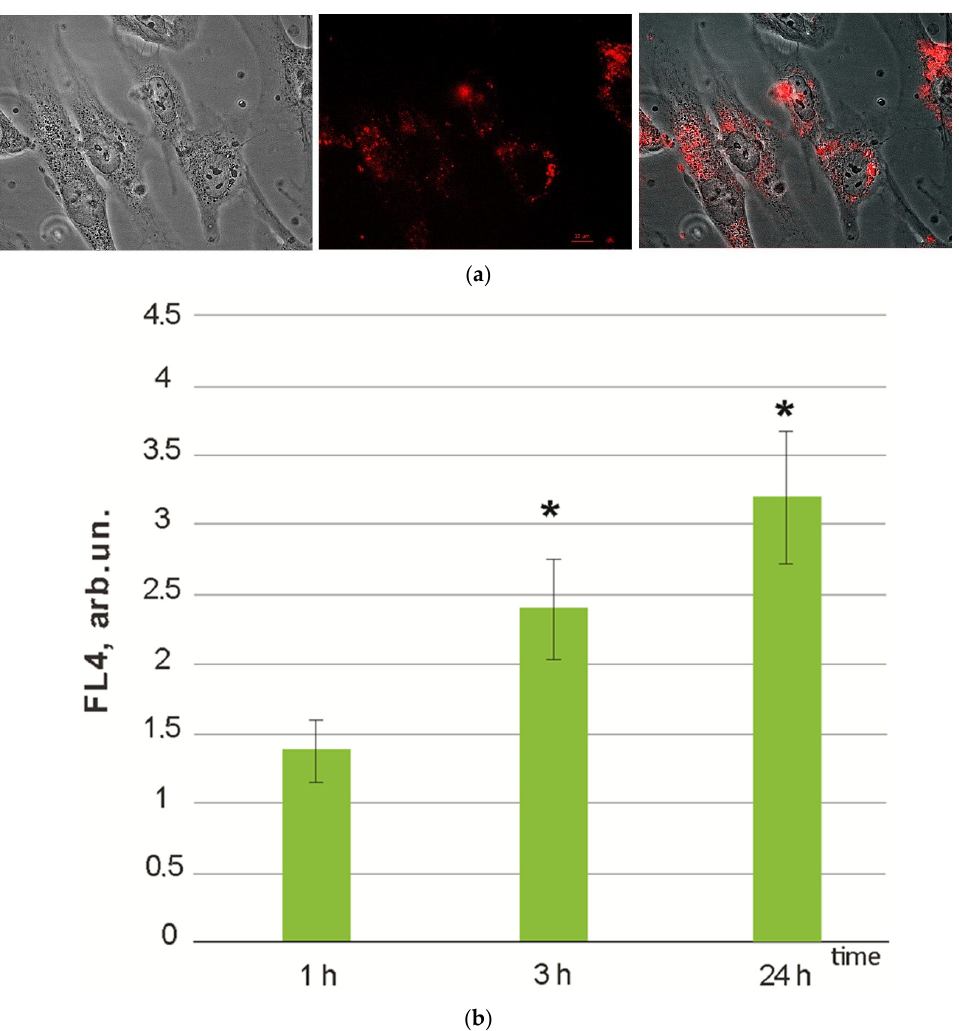
Figure 3. ( a ) Fluorescence images of HELFs (40×) incubated with F1 (1.5 μ M) for 3 h in transmitted light (left), fluorescence (middle), and merged mode (right) using a 575–645 nm excitation filter (#6) and a 530–555 nm emission filter; ( b ) median values of FL4 signal in non-fixed cells vs. cultivation time. “*”- According to the Mann − Whitney test, the signals after 3 and 24 h differed significantly from the control value ( p < 0.01).